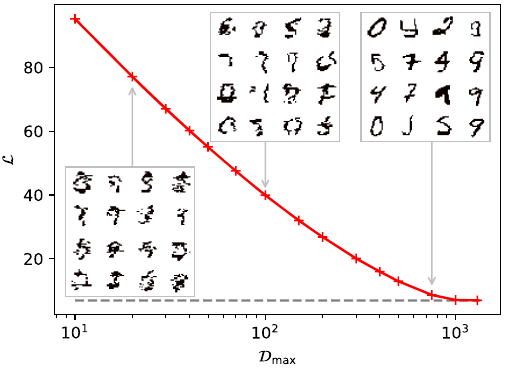
FIG. 3. NLL average of a MPS trained using j T j ¼ 1000 MNIST images of size 28 × 28 , with varying maximum bond dimensions D . The horizontal dashed line indicates the max Shannon entropy of the training set ln j T j , which is also the minimal value of L . The inset images are generated by the MPS trained with different D (denoted by the max